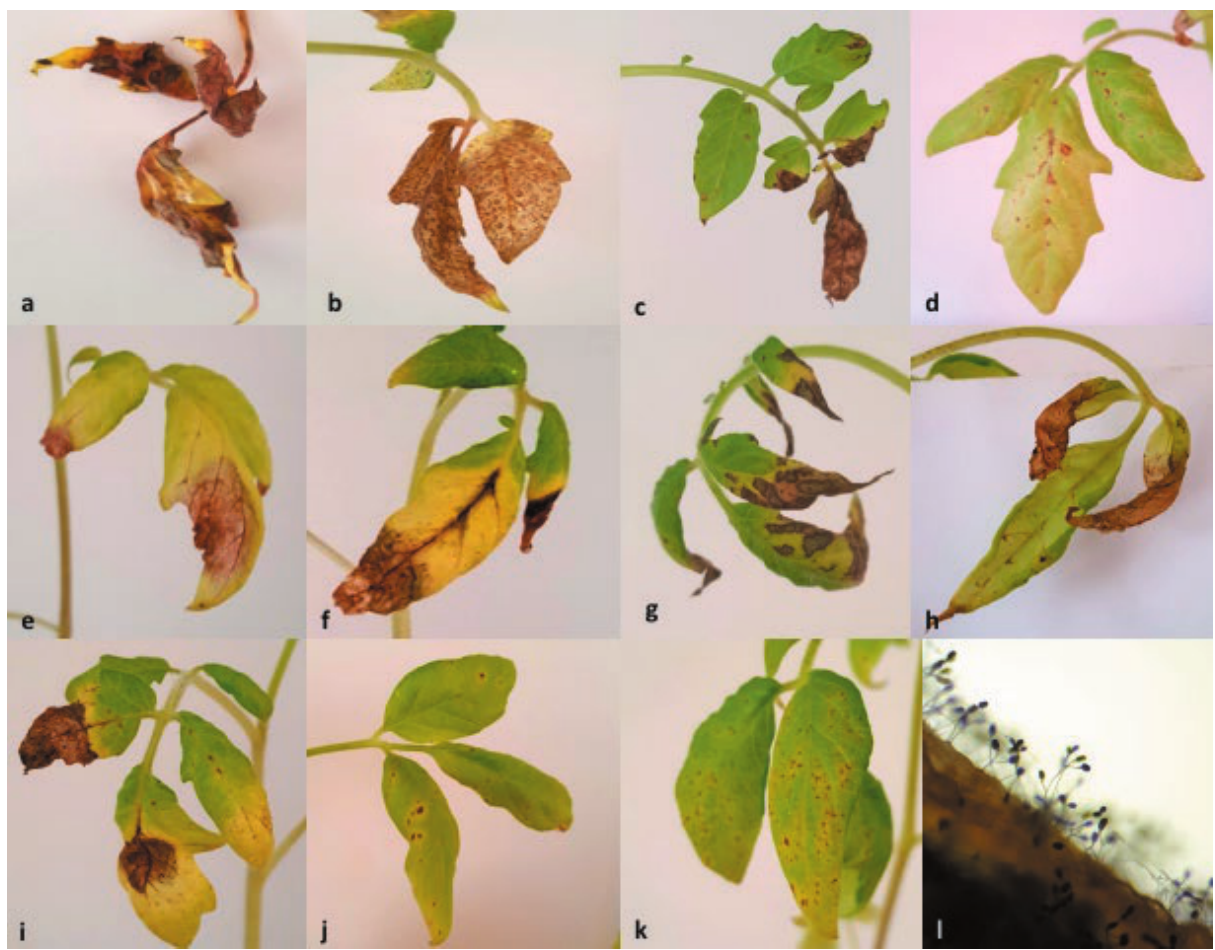
Figure 7. Lesions caused by Stemphylium spp. on tomato leaves 21 d after inoculation (dai). S. lycopersici : NB744 (a), NB748 (b), NB747 (c); S. vesicarium ; NB731 (d), NB720 (e), NB737 (f); S. gracilariae : NB644 (g), NB646 (h); S. lycii : NB683 (i); S. eturmiunum : NB709 (j), NB712 (k). Stereomicroscope view (×40 magnification) of an inoculated tomato leaflet at 21 dai